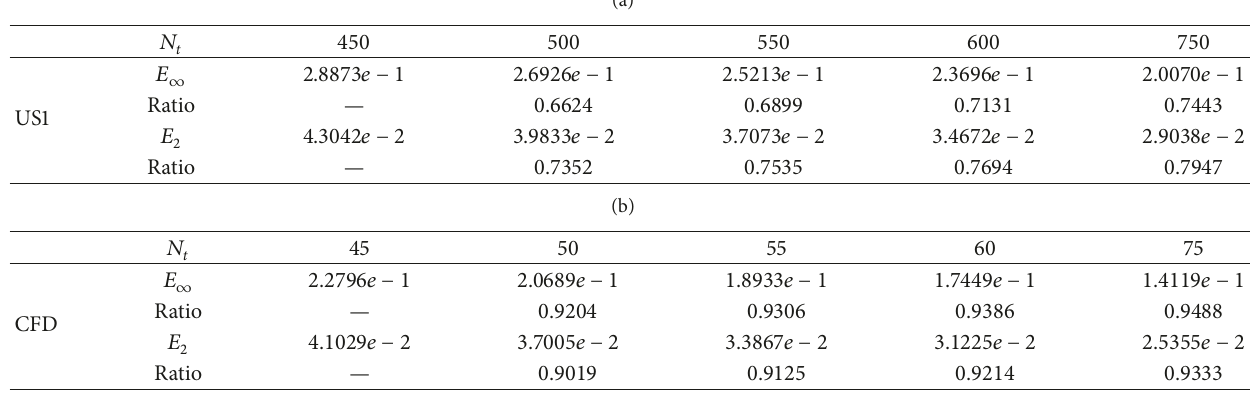
Table 2: Errors and ratios in time of the characteristic finite difference scheme (CFD) and the first-order upwind scheme (US1) using different